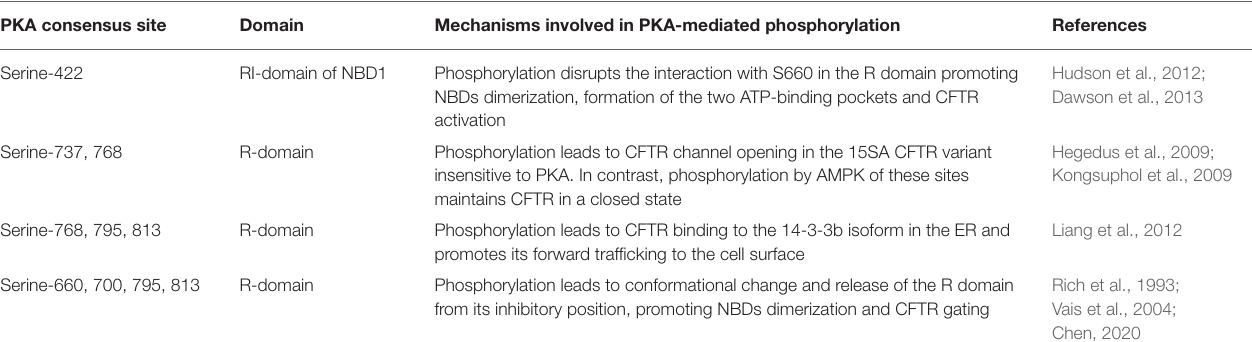
TABLE 1 | PKA phospho-sites in CFTR and their role in channel activity regulation. PKA consensus